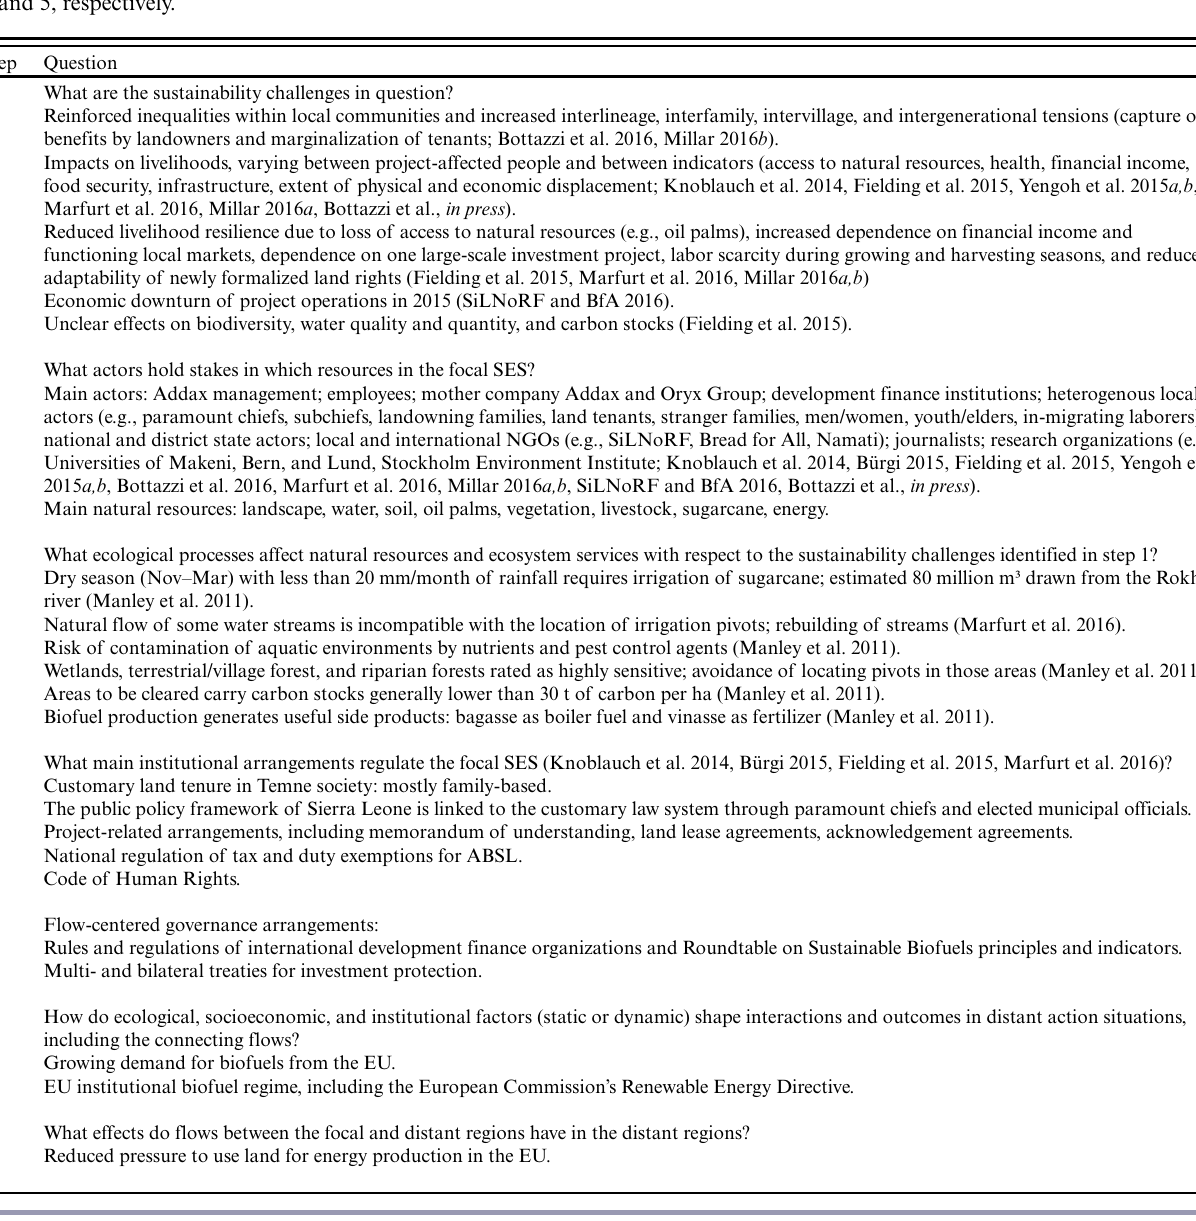
Table 2 . Applying the diagnostic procedure to the ABSL case (steps 1–4 and 6). Note: The results of steps 5 and 7 are shown in Figures 4 and 5,